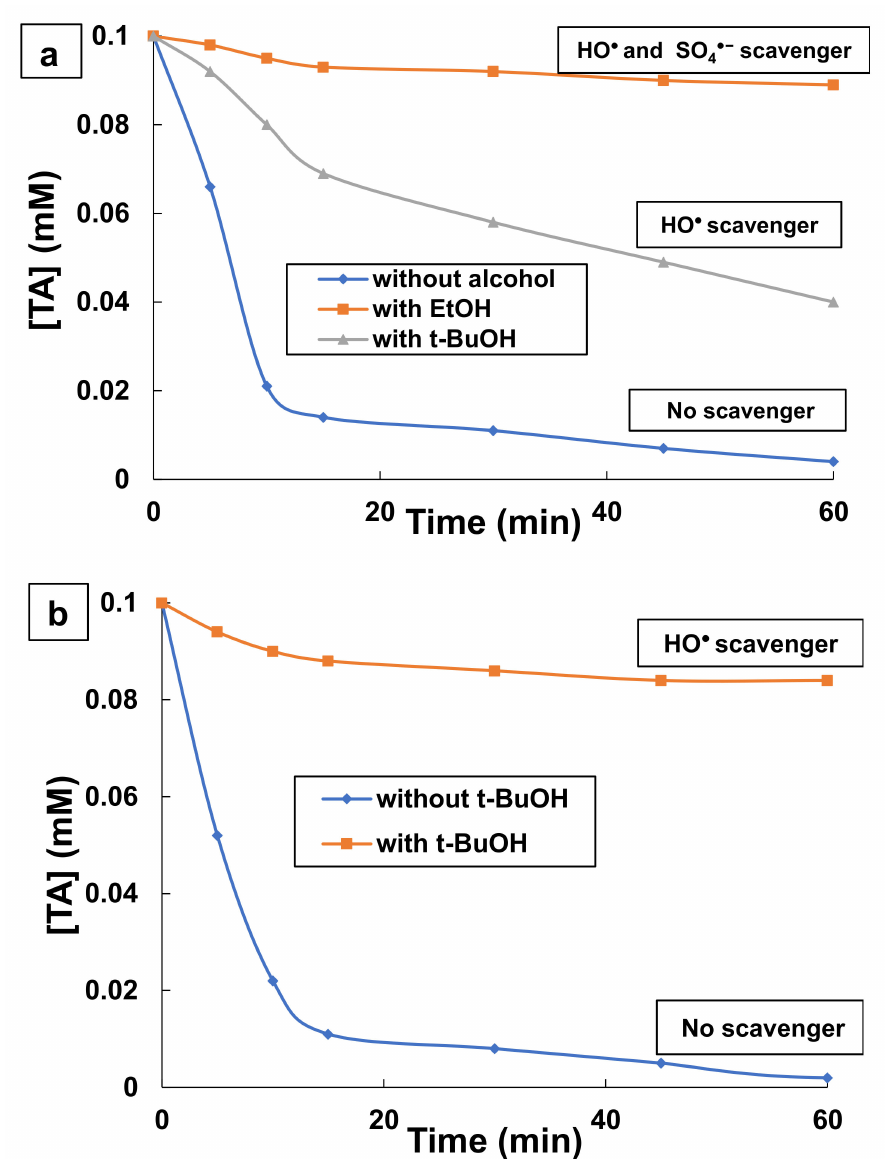
Figure 3. Effect of EtOH and t-BuOH as radical scavengers on TA degradation efficiency during ( a ) UV/persulfate and ( b ) photo-Fenton oxidation. Experimetal conditions: (( a ) UV/PS: [TA] = 0.1 mM, [EtOH] = 50 mM, [t-BuOH] = 50 mM, [K 2 S 2 O 8 ] = 53.1 mM, pH = 9 and T = 25 ◦ C; ( b ) UV/H 2 O 2 /Fe 2+ : [TA] = 0.1 mM, [t-BuOH] = 10 mM, [H 2 O 2 ] = 29.4 mM, [Fe 2+ ] = 0.18 mM, pH = 3, and T = 25 ◦